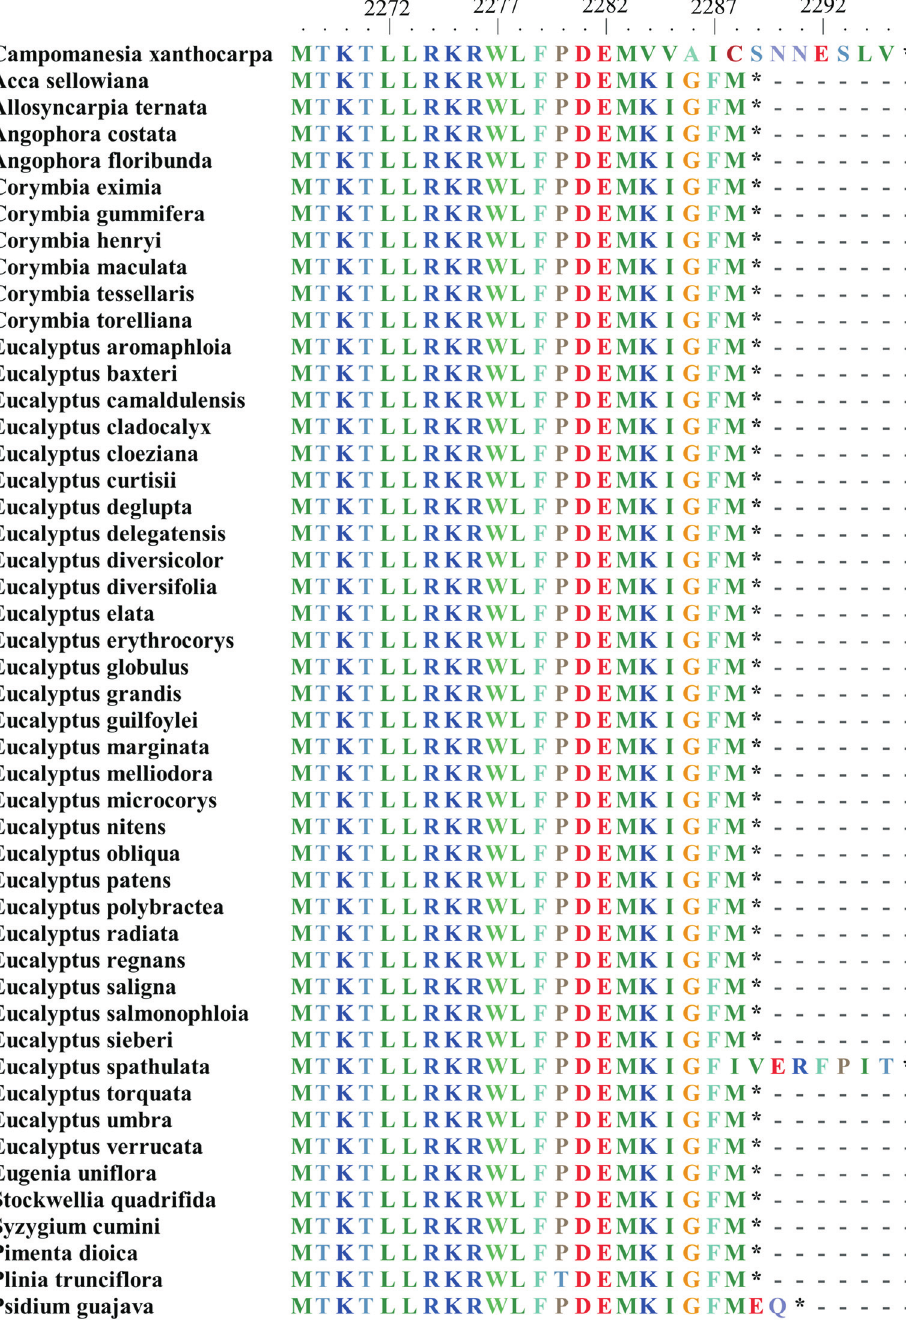
Figure 3 - Comparison of the C-terminal region of the amino acid sequences of the ycf2 gene in 47 species of